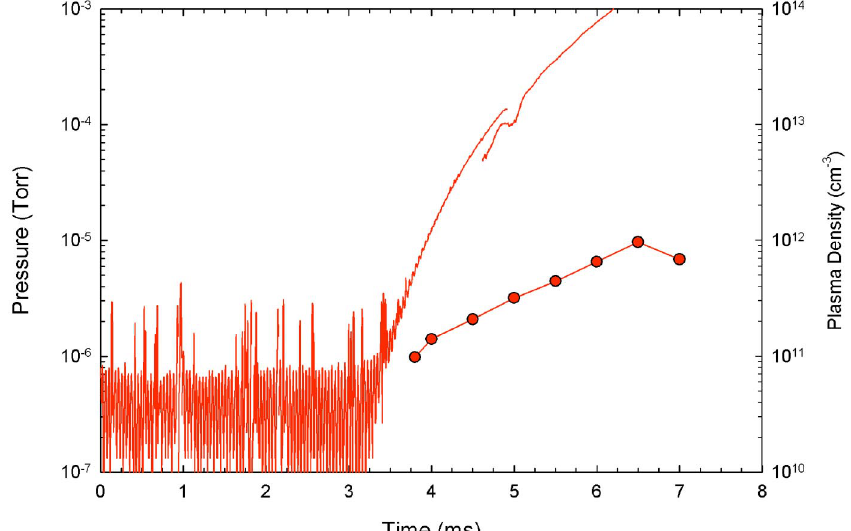
FIG. 31. (Color) Time evolution of neutral gas pressure and plasma electron density (solid circles) in the pulsed plasma source. One upgrade under consideration is replacing the gas valve with a faster one to reduce the length of the gas puff and the total amount of gas into the system. Another upgrade would use a pulsed rf supply to increase the rf power level.